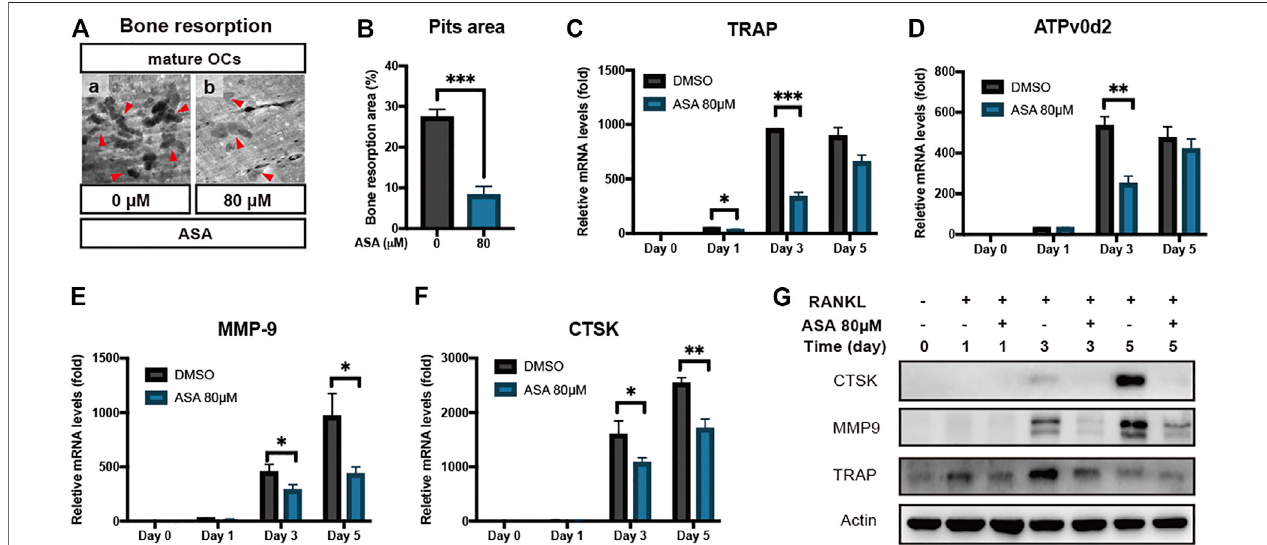
FIGURE2| ASAinhibitedRANKL-inducedboneresorptionandrelatedgeneexpressions. (A) EffectofASAonboneresorptionofmatureOCs.BMMswereplated on bone slices in 96-well plate and then differentiate into mature OCs by M-CSF and RANKL. Then ASA (0.1% DMSO as a control) was incubated with mature OCs for 2 days and bone slices were fi xed. Images were shown as ×200magni fi cation. The resorption pits in each image were indicated by the red triangles. (B) The pit areas werequanti fi edusingImageJsoftwareandpresented graphically (C) BMMswerestimulatedwithM-CSFandRANKLinthepresenceof80 μ MASA(0.1%DMSO asacontrol)for1,3, 5 days.OCsmarkergenelevelsof (C) TRAP (D) ATPv0d2 (E) MMP9 (F) CSTKweredeterminedbyquantitativeRT-PCR analysis.Theresults were normalized to β -actin expression and expressed asfold change relative togeneexpression in control cells. * p < 0.05, ** p < 0.01, *** p < 0.001 vs control (G) BMMs